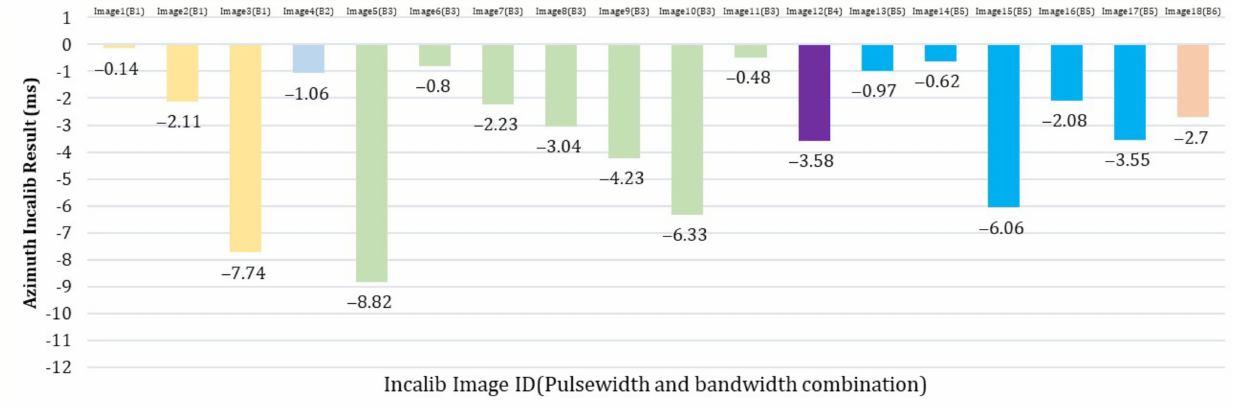
Figure 12. Azimuth time calibration values of 18 Incalib images.